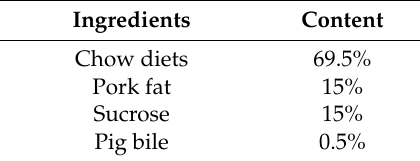
Table 2. Composition of the high fat diets.